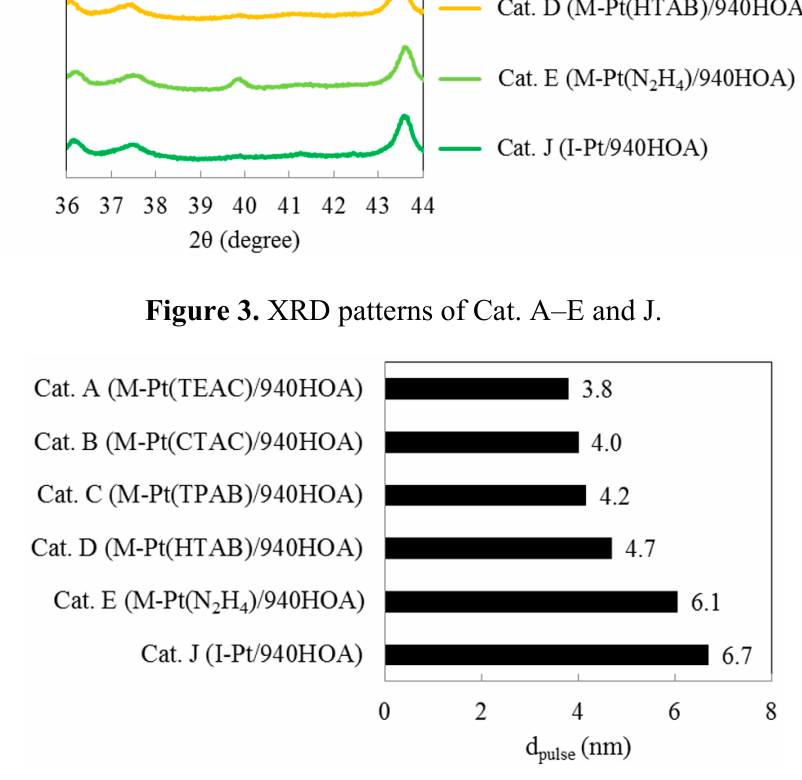
Figure 4. d pulse of Cat. A–E and